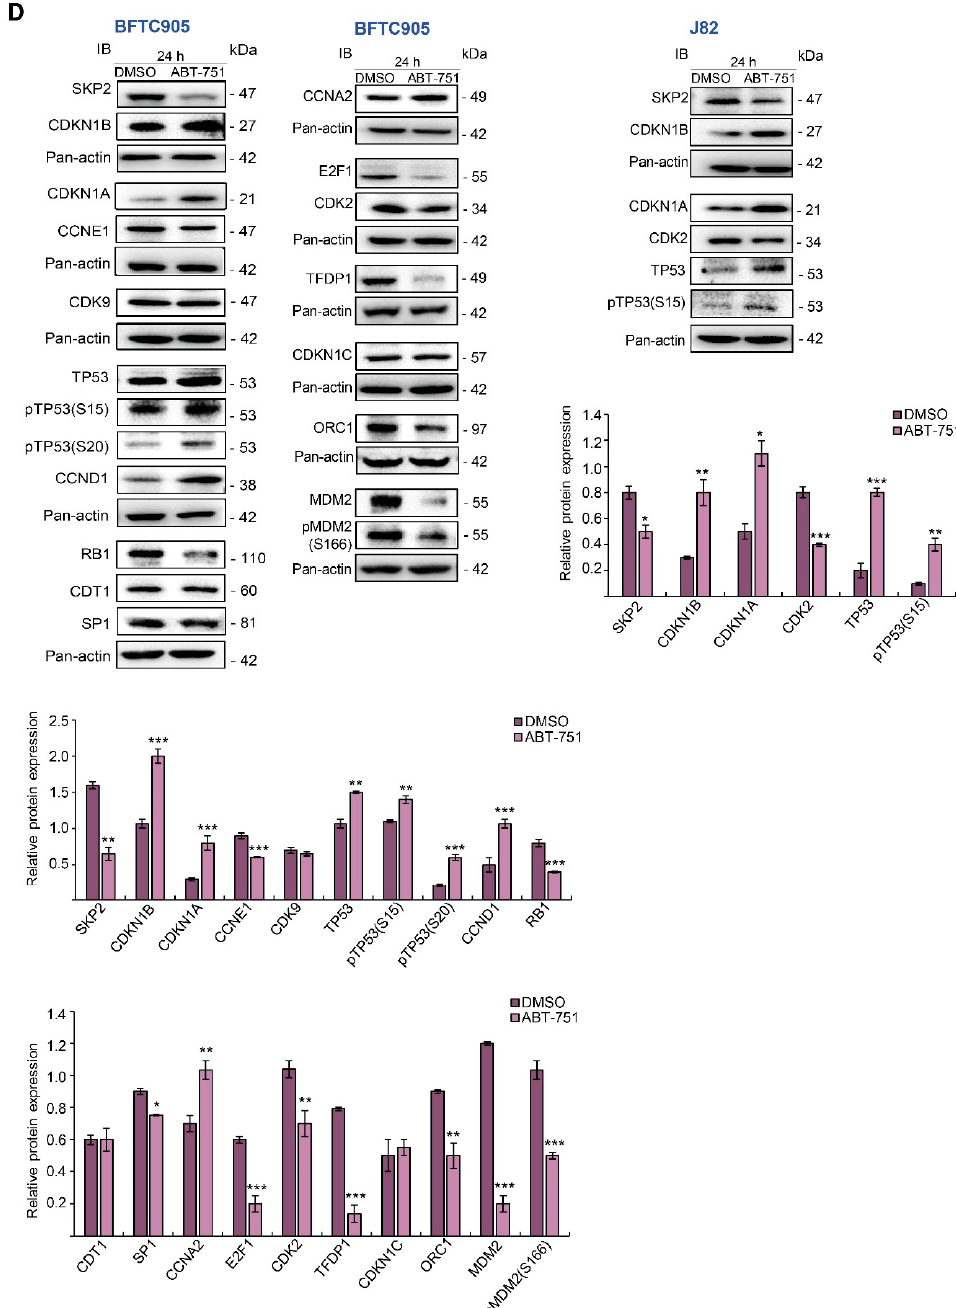
Figure 1. ABT-751 induces cytostasis and alters the protein expression levels of several cell cycle regulators in urinary bladder urothelial carcinoma (UBUC) cell lines. ( A ) UBUC-derived cell lines, BFTC905 and J82 were treated with different concentrations of ABT-751 or DMSO for the indicated time (24, 48 and 72 h), cell viability was next measured by the 3-(4, 5-dimethylthiazol-2-yl)-2, 5-diphenyltetrazolium bromide (MTT) assay. ( B ) The cells were treated with a specified concentration (BFTC905, 0.6 µ M and J82, 0.7 µ M) of ABT-751 for 24 h, and the cell cycle distribution was determined by flow cytometry. ( C ) After 7 days of ABT-751 treatment, colony formation and anchorage-independent cell growth were suppressed. Each arrow points to one colony. Scale bar: 100 µ m. ( D ) The cells were treated with a specified concentration (BFTC905, 0.6 µ M and J82, 0.7 µ M) of ABT-751 for 24 h and the protein expression levels of several cell cycle regulators were determined by immunoblots. Relative protein expression of indicated proteins was quantified using ImageJ software (1.52a, NIH, USA). The results are expressed as the means ± SD. Pan-actin served as a loading control in each gel for immunoblot analysis. Statistical significance: * p < 0.05, ** p < 0.01, *** p <